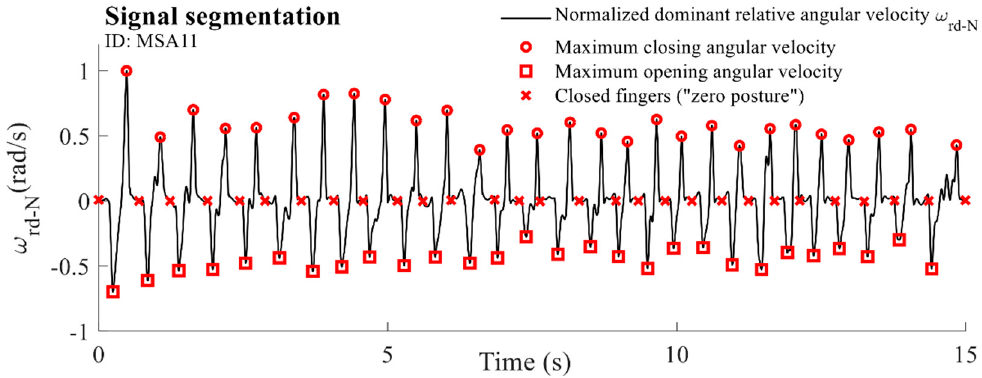
Figure 3. An example of the normalized dominant component of the relative angular velocity 𝜔 (cid:2928)(cid:2914) for one MSA patient (ID: MSA11) with extracted